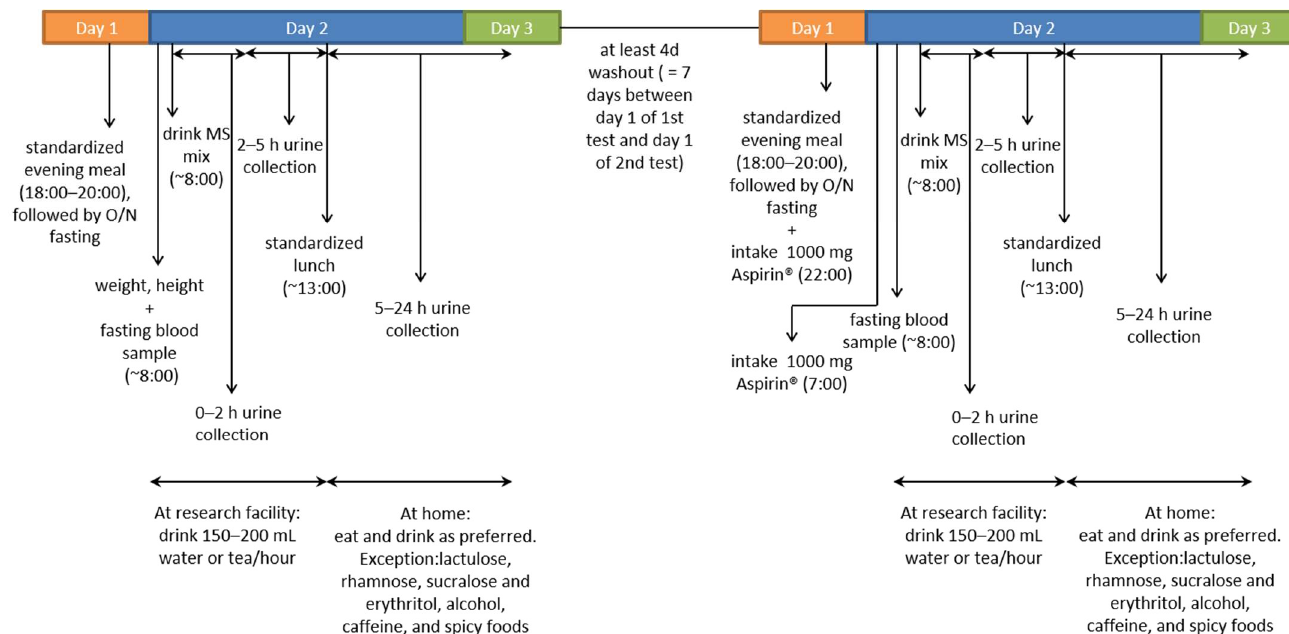
Figure 2. Schematic overview of the study design.